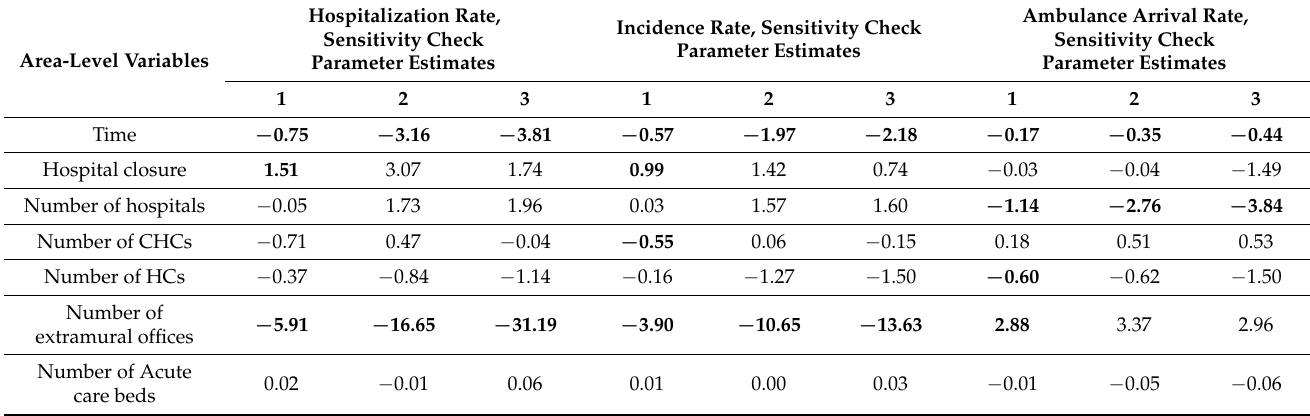
Table 4. Robustness